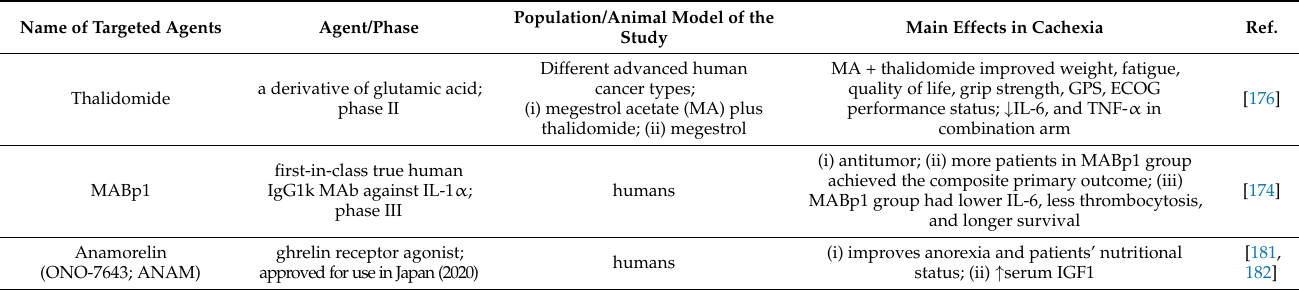
Table 3. Therapeutical options in the management of cancer cachexia in solid cancers (including CRC). Name of Targeted Agents Agent/Phase Population/Animal Model of the Study Main Effects in